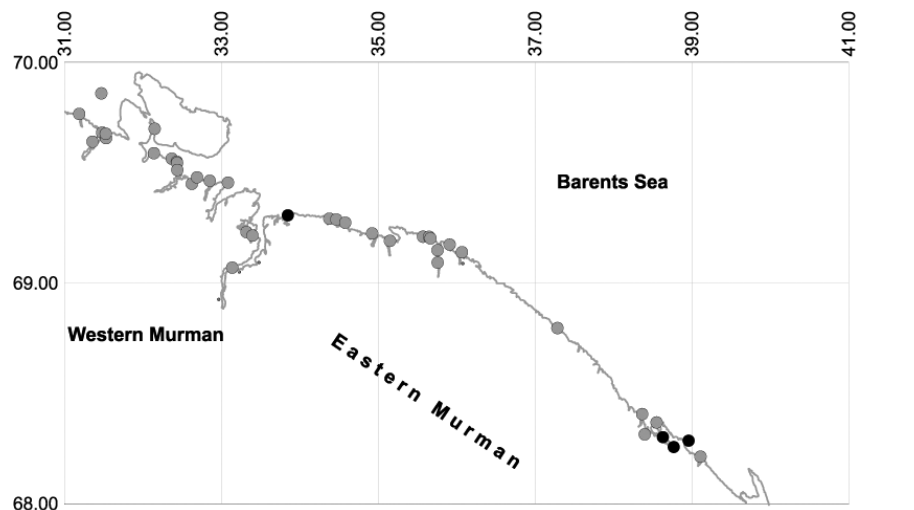
Fig. 2. Observations of harbour seals on the Murman coast of the Barents Sea. Black dots: above 50